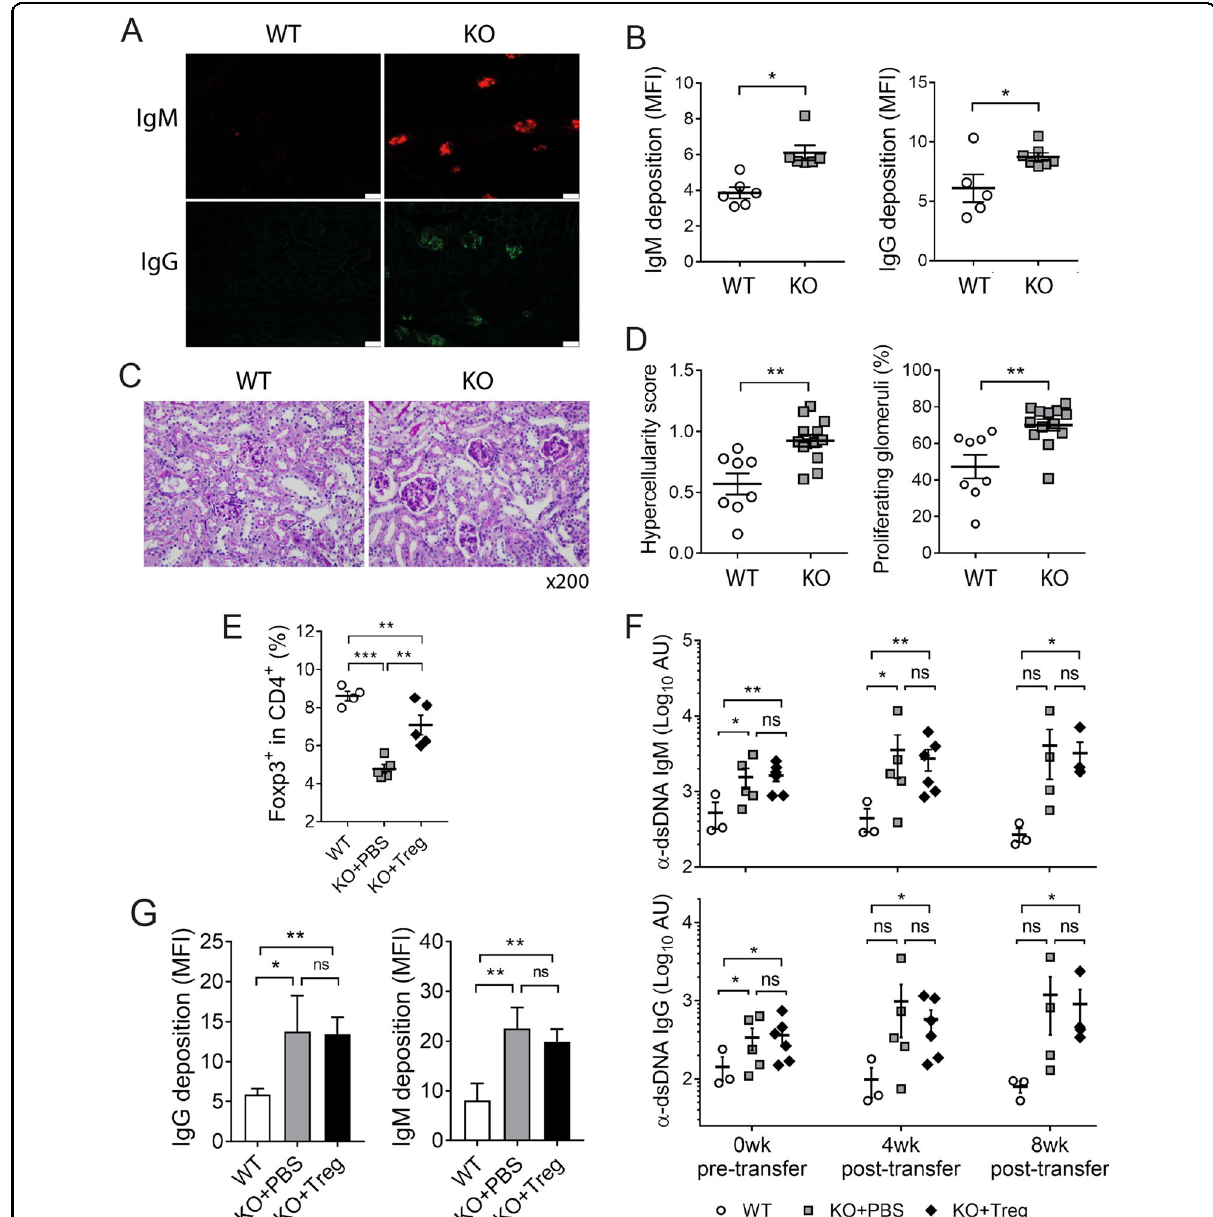
Fig. 2 Histopathologic manifestations of lupus nephritis and the effect of Treg reconstitution in Bach2 KO mice. a – d Kidneys from approximately 20-week-old Bach2 KO mice and their WT littermates were examined by histopathologic methods. Representative immunohistochemical images of kidney sections stained with anti-mouse IgM (upper fi gures) and IgG (lower fi gures) Abs and mean fl uorescence intensities (MFIs) a , b . Scale bar, 50 μ m. Representative images stained with periodic acid-Schiff and histopathologic indexes c , d . e – g Bach2 KO and WT mice were infused intravenously with normal syngeneic Foxp3 + Treg cells or PBS as a vehicle control. Foxp3 + CD4 + cells among spleen cells were examined 8 weeks after infusion e . Sera were collected from the recipients at the indicated times and assayed by ELISA f . All graphs display means ± SEMs, with symbols representing the values of individual mice. Kidney sections stained with anti-IgM or anti-IgG Abs were examined by confocal fl uorescence microscopy and displayed as the mean ± SEM MFI g . * p < 0.05, ** p < 0.01 and *** p < 0.001 by Student ’ s t -test. ns, not signi fi